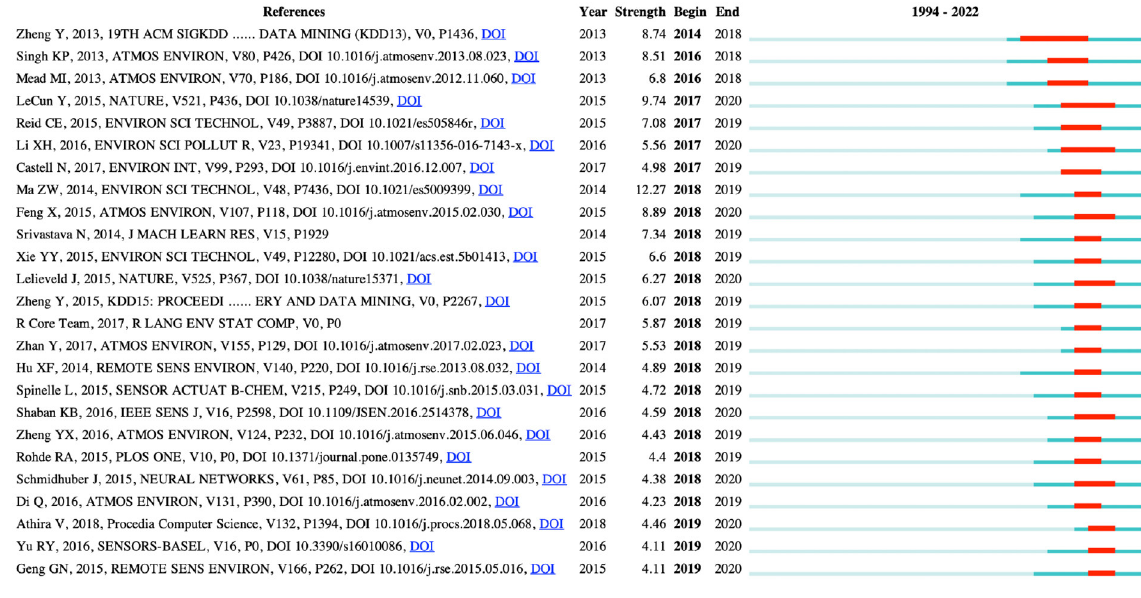
FIGURE5 The top 25 references with the strongest citation bursts. Articles with a high frequency of citations are represented by red bars, and those with a low frequency by green